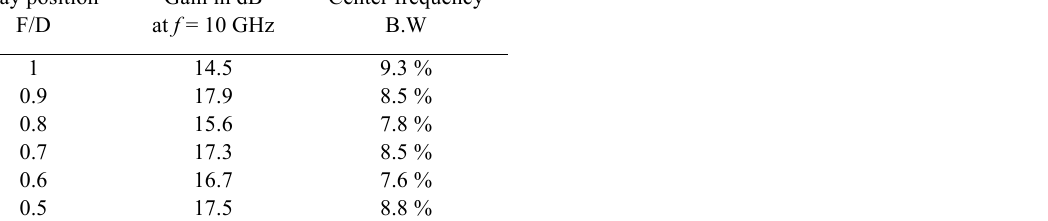
Figure 22: The E- and H- planes of circular polarization radiation patterns for the DRA loaded with transmitarray compared to a single DRA at f = 10 GHz.